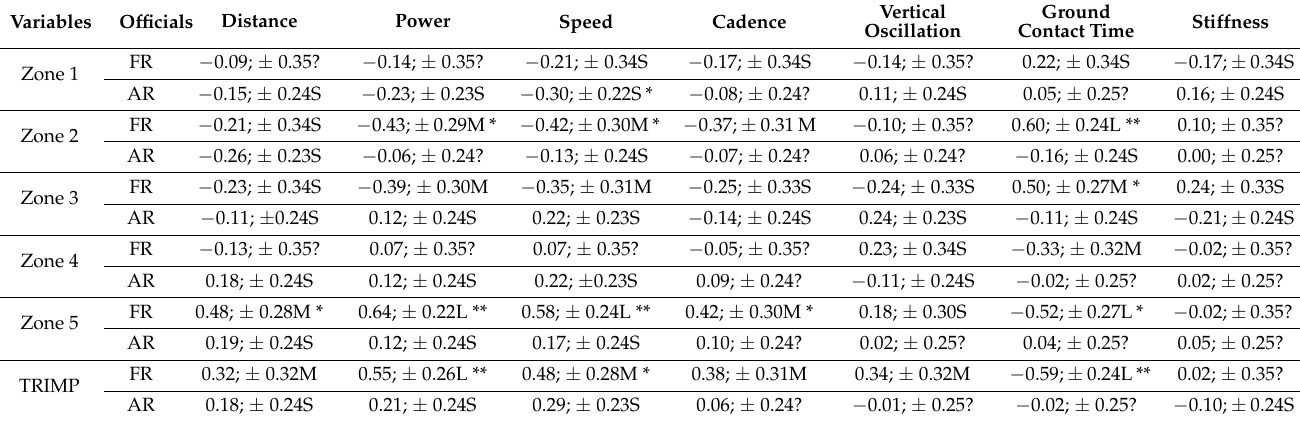
Table 2. Relationships (r/rho; ± 90% CL) between external and internal match loads for field (FR) and assistant referees (AR).